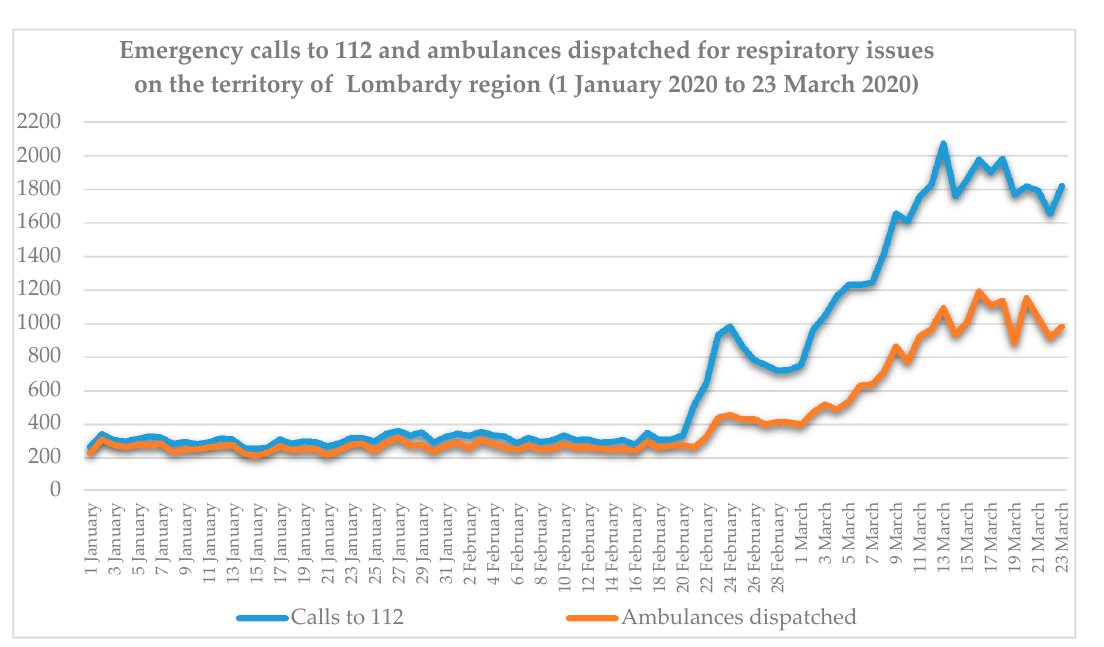
Figure 2. Day-by-day number of emergency calls to 112 and of ambulances dispatched in Lombardy region, from 1 January to 23 March 2020, in response to respiratory problems.